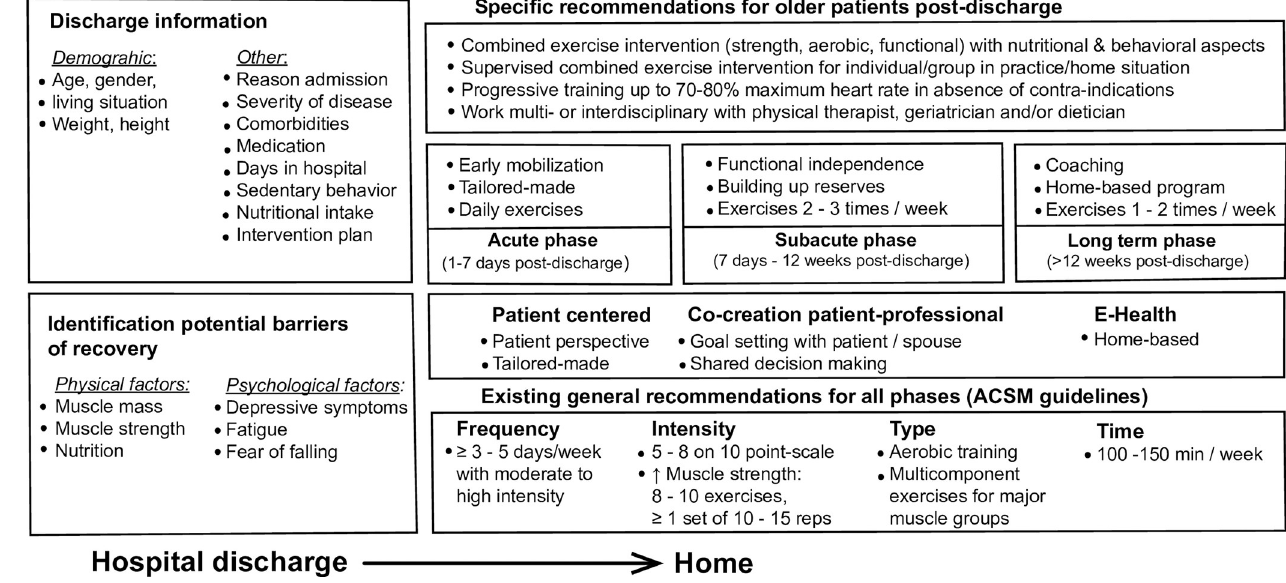
Fig 2. Recommended exercise intervention characteristics and handover information derived from this Delphi consensus process in addition to general recommendations for older patients after discharge from hospital.